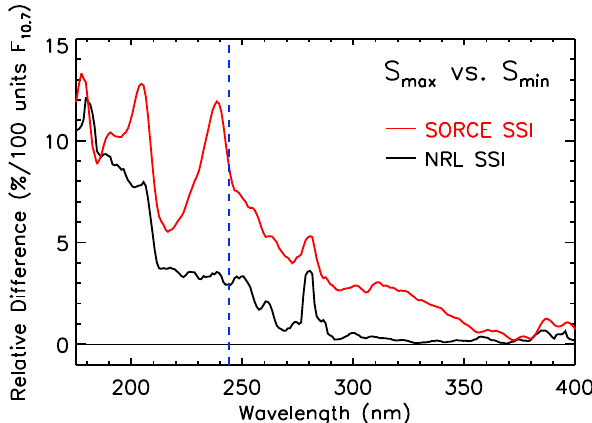
Fig. 1. SSI spectral differences, S max relative to S min per 100 units of F 10 . 7 , derived from NRL and SORCE SSI time series. The ver- tical dashed line at 244nm represents both the wavelength cut- off separating the SORCE SOLSTICE and SIM spectra used and the O 2 photolysis threshold (O 2 photolysis occurs at wavelengths shorter than